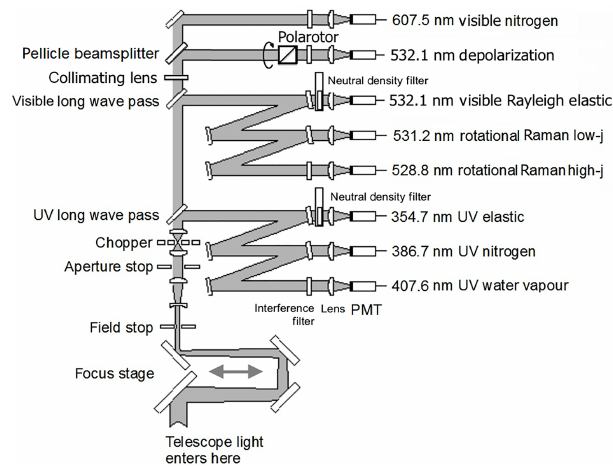
Figure 1. Diagram of CRL’s receiver system. The visible long-wave pass filter picks off approximately 97% of the received 532nm light and directs it toward the visible Rayleigh elastic (polarization- independent) channel and transmits the remainder toward the de- polarization and visible nitrogen channels downstream. The pelli- cle beam splitter reflects 50% of this residual 532nm light toward the Polarotor and into the depolarization channels’ detector (parallel and perpendicular polarization-sensitive channels, measured using the same PMT on alternate laser shots). The depolarization hard- ware, which was added in 2010, consists of the pellicle beam split- ter, the Polarotor, and the interference filter, focusing lens, and PMT to the right of the Polarotor in this figure (McCullough et al., 2017). No other receiver optics were modified in order to reduce the impact of this depolarization upgrade on the pre-existing lidar channels. A consequence of this choice is that the count rates are much higher in the visible Rayleigh elastic polarization-insensitive channel than they are in either the parallel or the perpendicular channel. This fig- ure is based on Fig. 2 of Nott et al.